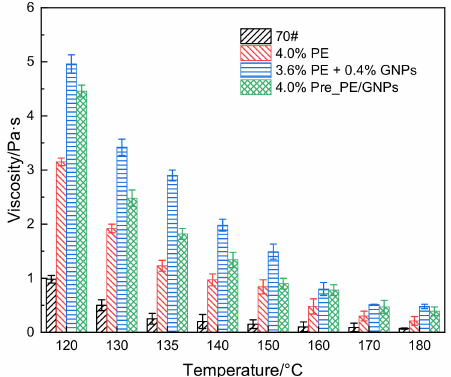
Figure 4. Viscosity–temperature trend of PE/GNPs composite modified asphalt and control asphalt